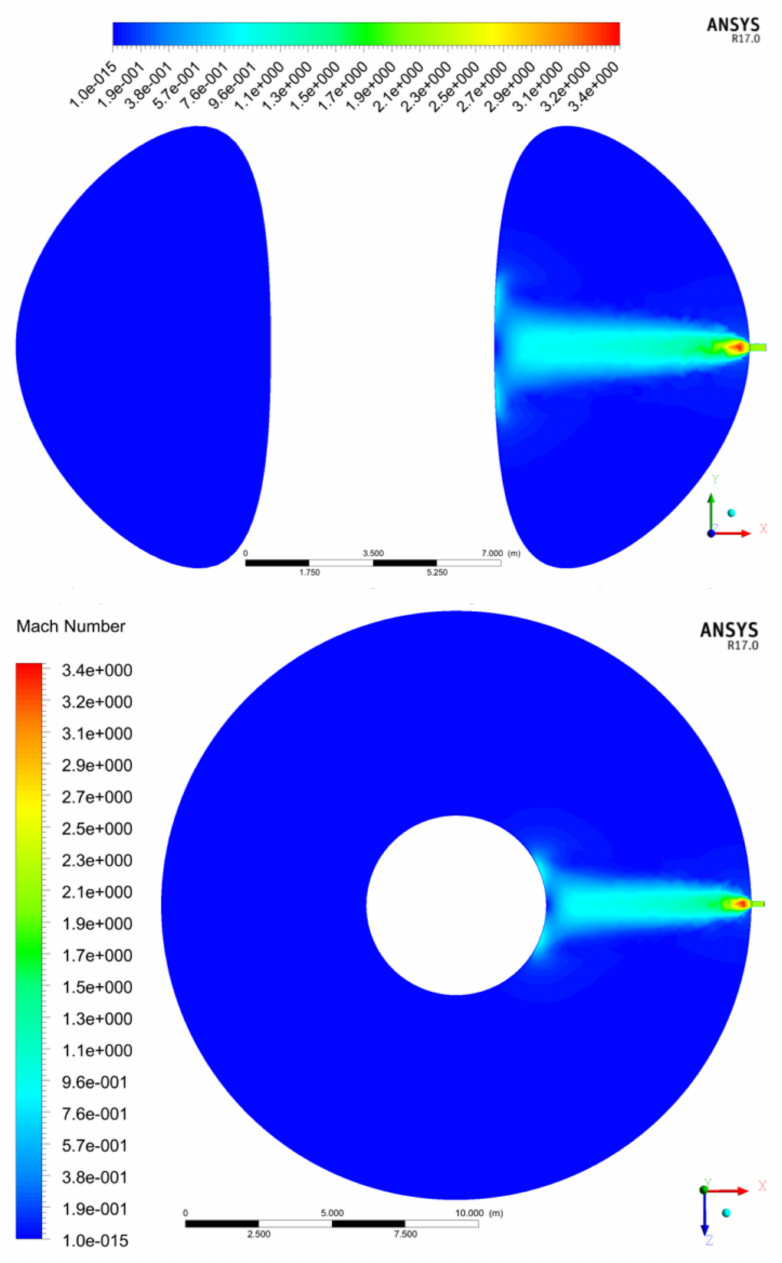
Figure 7. Mach number on the xy plane ( top ) and zx plane ( bottom ) at 7 × 10 − 2